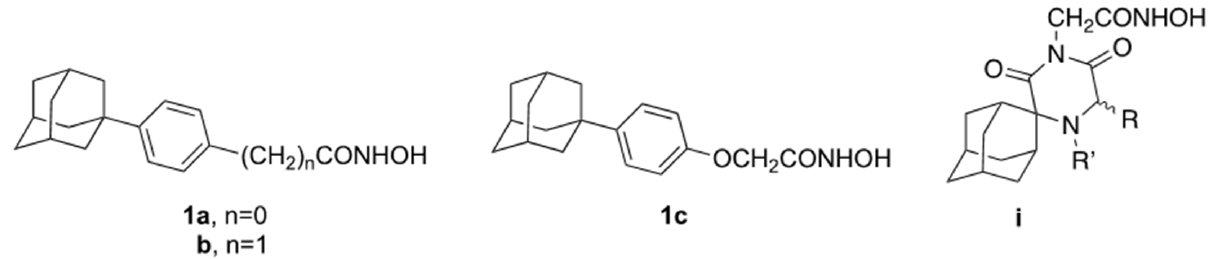
Figure 1. Adamantane hydroxamic derivatives with anti-trypanosomal activity.